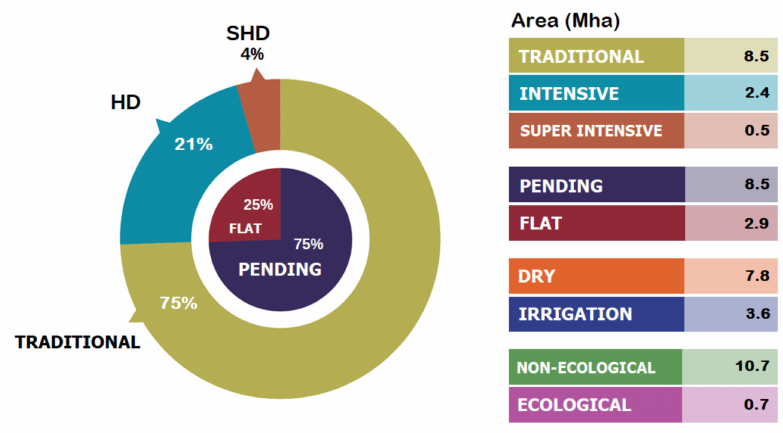
Figure 3. Traditional and modern systems of olive